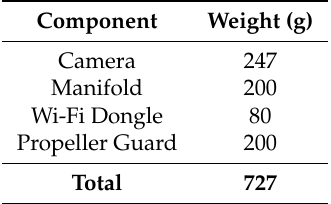
Table 4. Payload distribution of the devices mounted on the